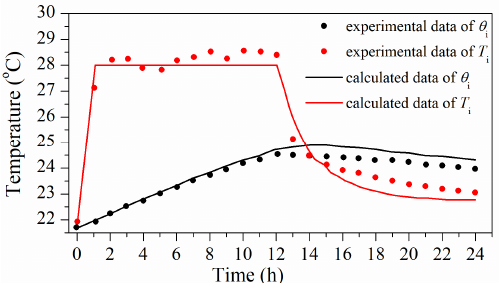
Figure 6. Comparisons between the calculated and experimental data of indoor air and interior surface temperature.